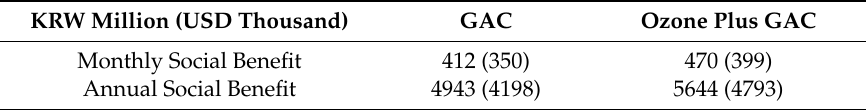
Table 10. Social benefits of improving drinking tap water